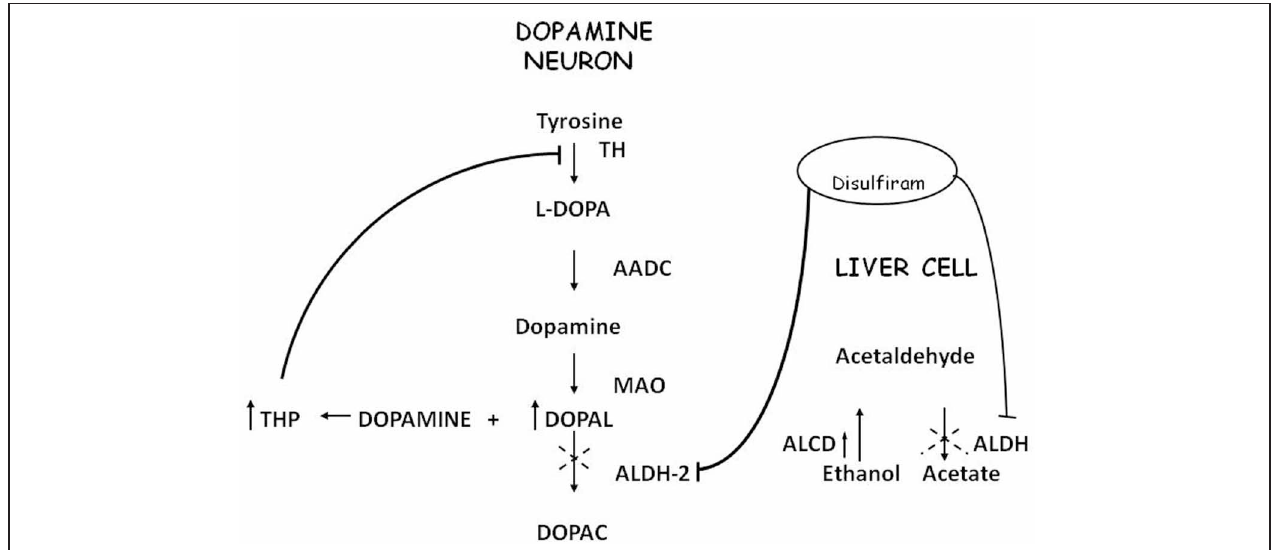
FIGURE 1 | Convergence of metabolic pathway for acetaldehyde and